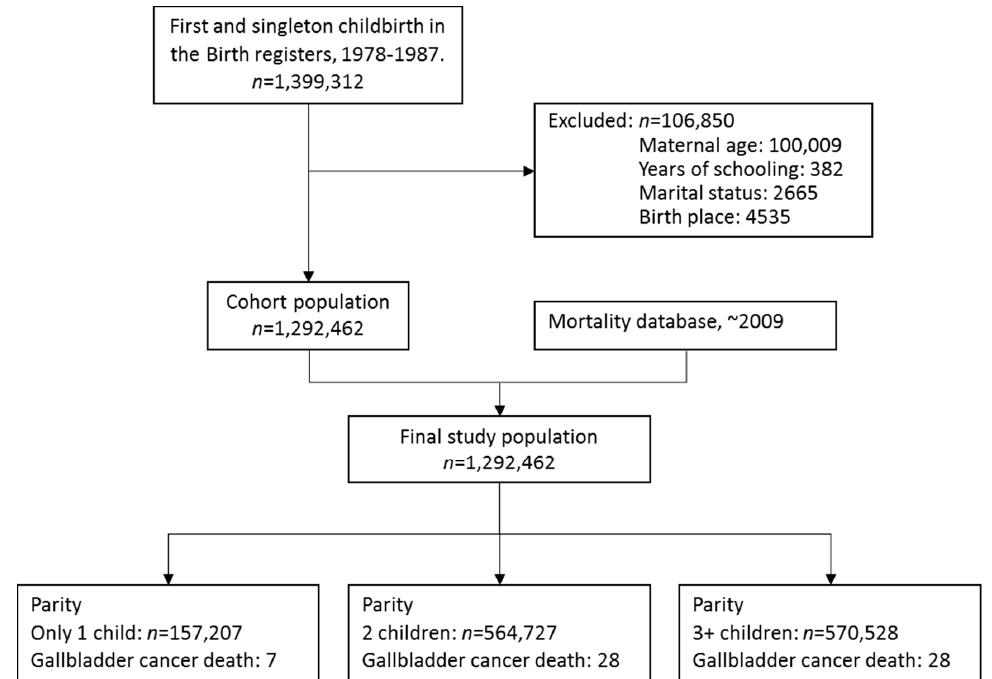
Figure 1. Flowchart of study subject selection.